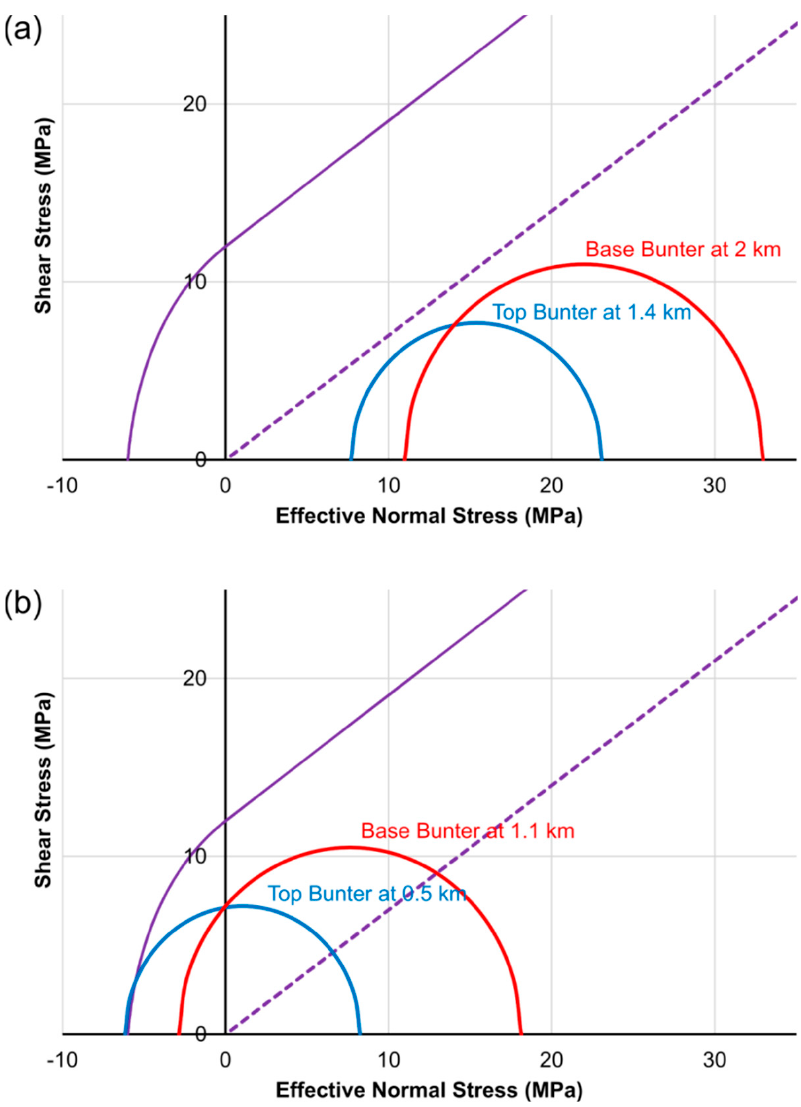
Figure 6. Mohr diagrams illustrating the possible effects of exhumation and cooling on the Bunter Sandstone. See Table 5 for parameters used in the model. ( a ) Model for the base of the Bunter Sandstone at a depth of 2 km and the top of the Bunter Sandstone at 1.4 km. The model predicts the rock is in a stable stress state. ( b ) Model for the Bunter Sandstone after 0.9 km exhumation. The top of the Bunter Sandstone is now at a depth of 0.5 km, and the stress state promotes the development of steeply-dipping extension fractures. Notice that the differential effecting stresses in ( a , b ) are similar, because cooling during exhumation tends to generate horizontal tensile stresses.